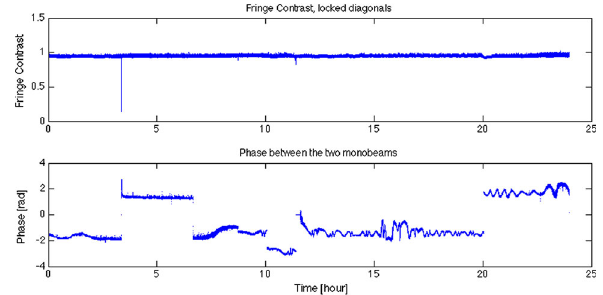
Fig. 5 Top: fringe contrast during geometry control of GP2, a few features suggesting mode jumps are shown. Bottom: the relative phase between the two modes (cid:7) is shown. In correspondence of the jumps there is a rapid change in